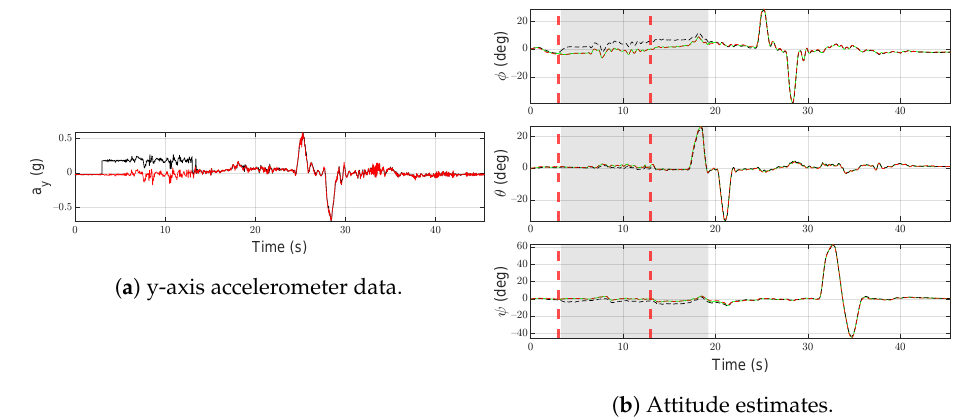
Figure 7. Scenario F1. Black lines denote measurements/estimates from IMU-1, red lines are for measurements/estimates from IMU-2. Green lines are for SFDI output, gray areas highlight the time interval in which the SFDI algorithm is in the fault state. Vertical red dashed lines denote the time instants when the fault occurs and